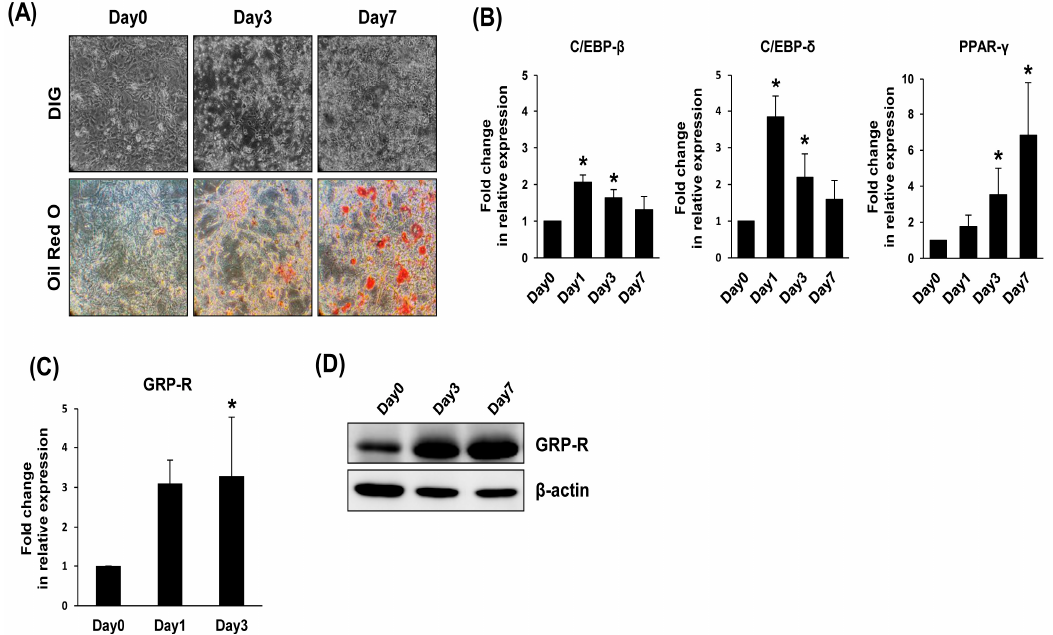
Figure 1. The expression of GRP-R (Gastrin-releasing peptide receptor) in adipocyte differentiation of 3T3-L1 cells. Preadipocyte 3T3-L1 cells were induced to differentiate by the addition of DMI (DEX, IBMX, and insulin) for the indicated times. ( A ) During adipogenic differentiation, changes in cell morphology were observed by a phase contrast microscope at 200 × magnification, and oil red O staining was performed. ( B ) Total RNA was isolated during adipogenesis. The adipocyte specific markers (C/EBP- β , C/EBP- δ , and PPAR- γ ) were investigated by real-time PCR. The level of expression was normalized to 36B4. Each value represents the mean ± SD from three independent experiments. * p < 0.05 compared to Day 0. ( C ) The mRNA expression of GRP-R during 3T3-L1 differentiation was measured by real-time PCR. * p < 0.05 compared to Day 0. ( D ) The level of GRP-R protein was detected using the specific antibody. β -actin was used as the internal control.